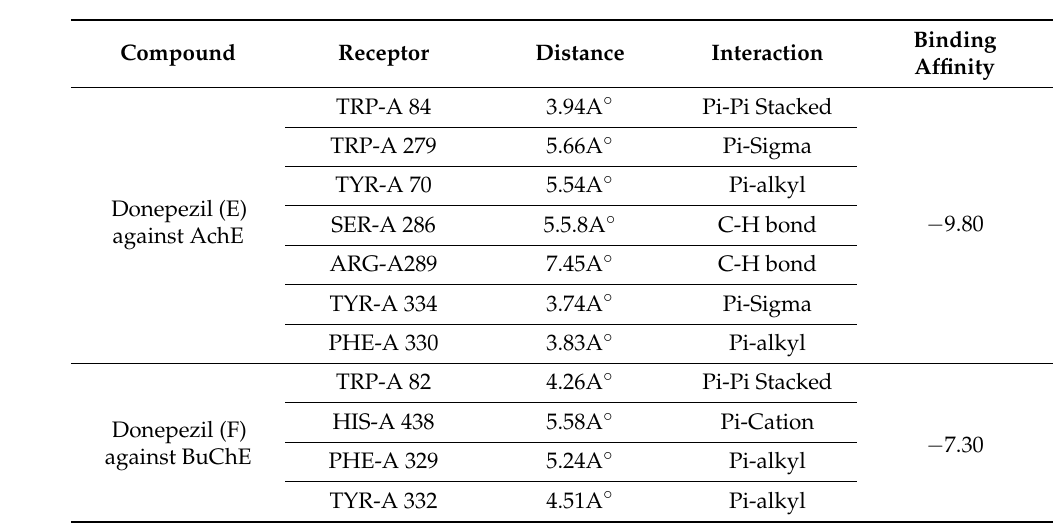
Figure 14. Representation of the PLI profile for donepezil against BuChE. Table 2. Protein–ligand interaction profile for most potent compounds ( 1 and 10 ) and standard drug . Compound